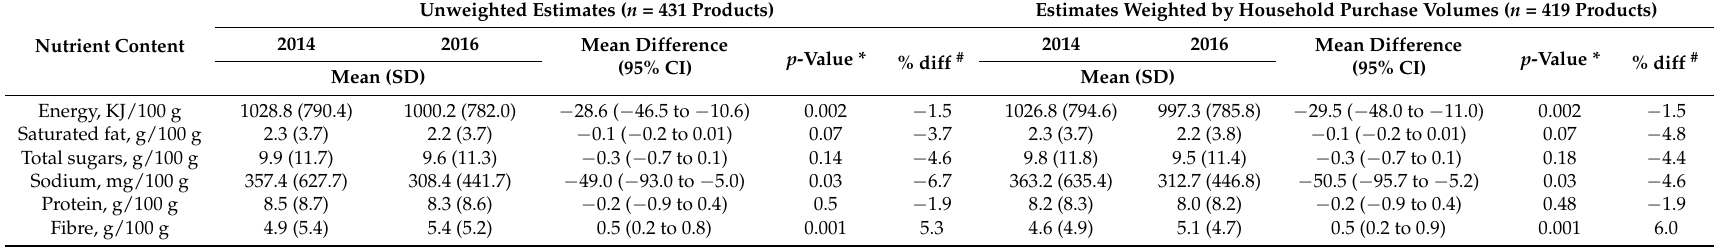
Table 2. Composition of products displaying HSR labels in 2016 and composition of the same products in 2014 prior to introduction of